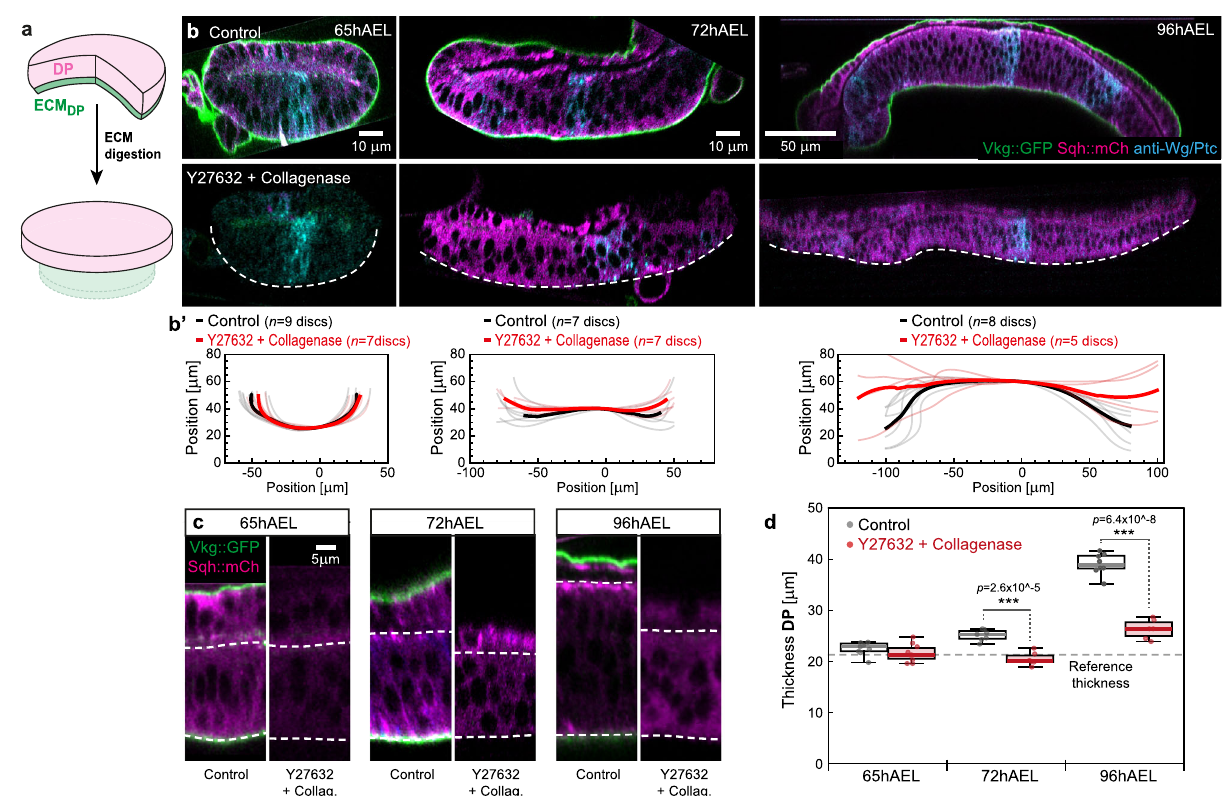
Fig. 3 | The ECM constraints planar epithelial growth and is required for disc doming. a Acute digestion of the ECM shell by Collagenase leads to relaxation of the epithelial layers. b Top: representative sections of control wing discs at indi- cated stages of development marked for the ECM (Vkg::GFP, green) and MyoII (Sqh::mCh, magenta). Bottom: representative wing discs after acute digestion of the ECM by Collagenase and inhibition of MyoII (by Y-27632, see 'Methods'). DashedlinemarksDPbasaloutline. b ’ Averagebasaloutlinesbefore(blackline)and afterECMdigestion+MyosinIIinhibition(redline). c Cross-sectionsofcontroland ECM digested + MyoII inhibited wing discs. Apical and basal surface of the DP are